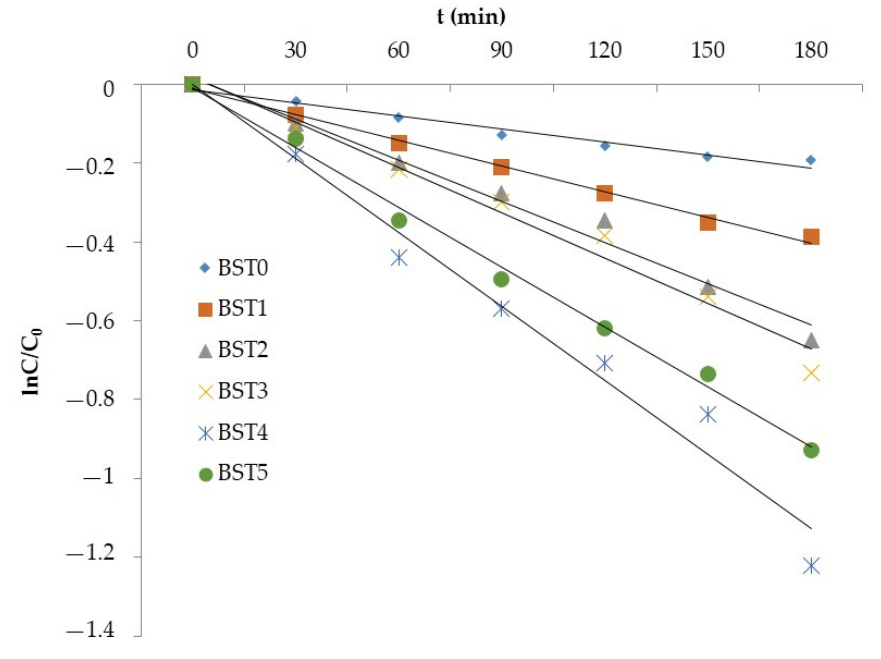
Figure 11. The reaction linetics curves of degradation of Gaseous formaldehyde in different Bi-doped levels of wood samples.